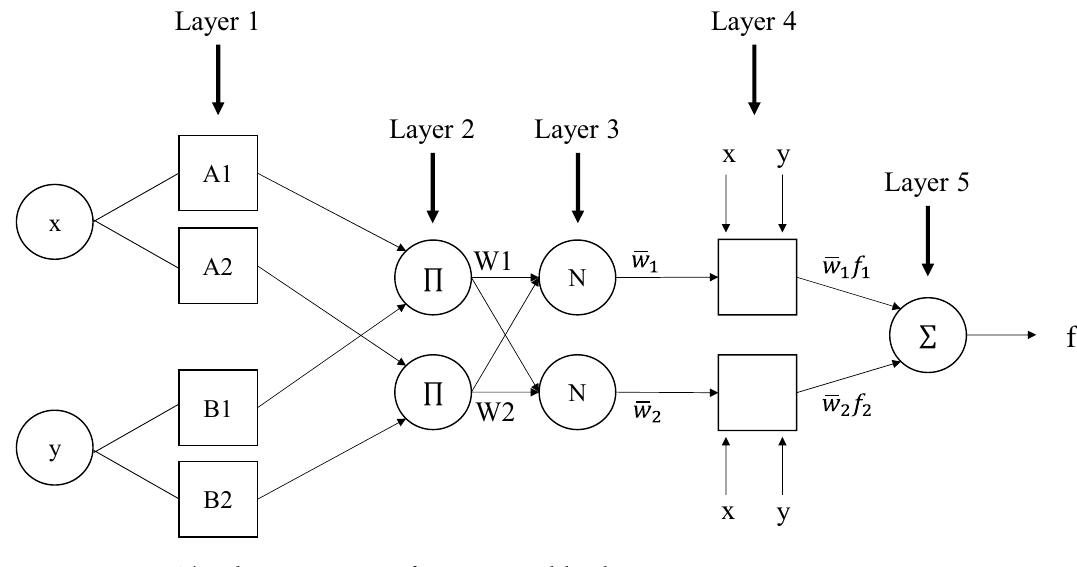
Figure 2. The schematic structure of an ANFIS model with two